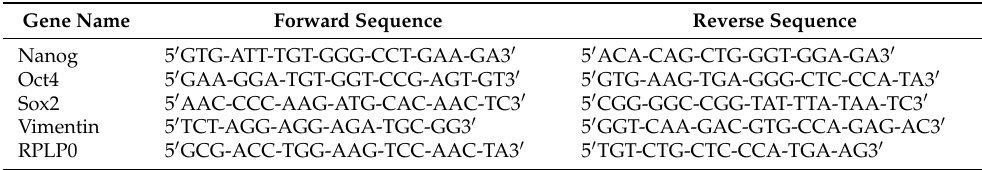
Table 1. Primer sequences for